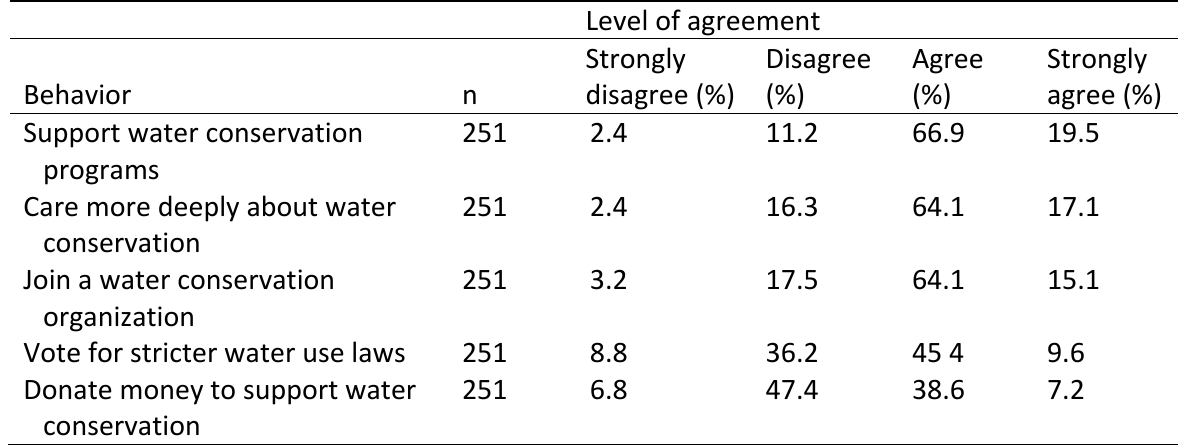
Student Agreement They Will Participate in Public-Sphere Behaviors Related to Water Conservation in the